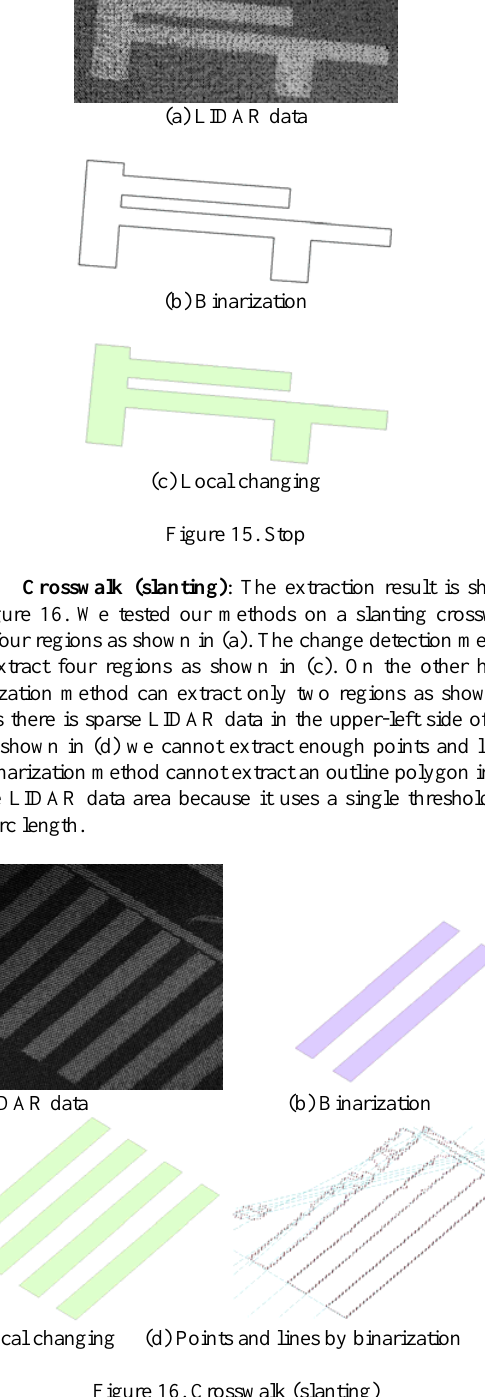
Figure 16. Crosswalk (slanting)